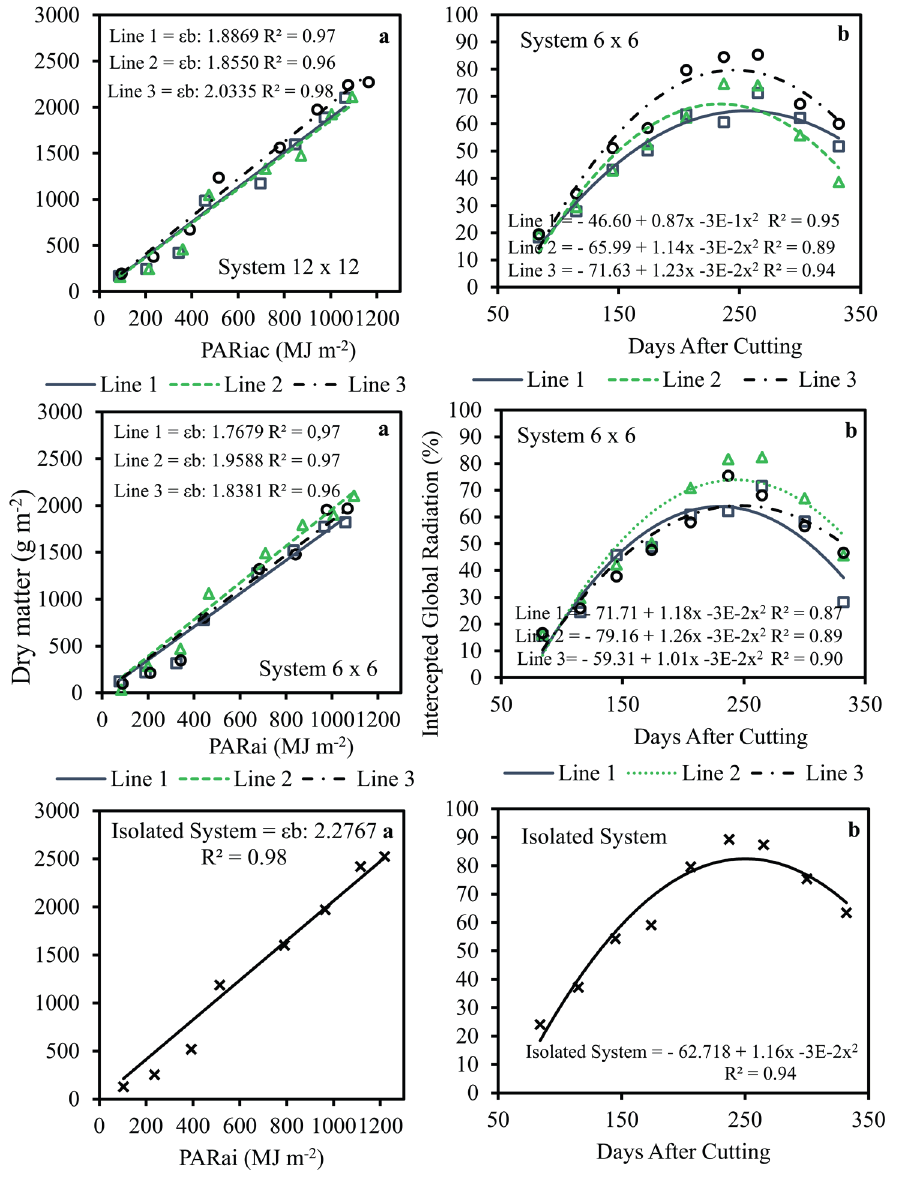
Figure 3 - The relationship between accumulated intercepted photosynthetically active radiation (PARiac) and dry matter produced (DM) ( a ); and intercepted global radiation of sugarcane in agroforestry and isolated systems in different lines of evaluation throughout the days after cutting ( b ). YIELD